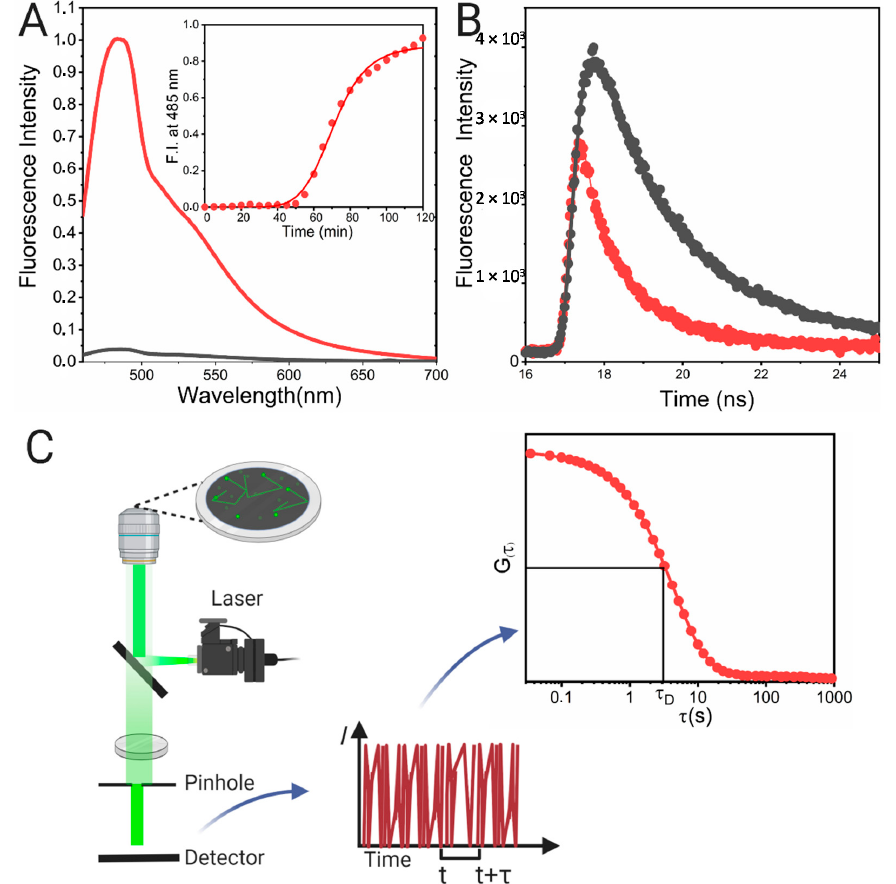
Figure 7. ( A ) Fluorescence spectra of Thioflavin T bound to BSA fibrils (red) in comparison to the probe without it (black). Inset: the kinetic of fibrils formation followed by fluorescence emission at 485 nm. ( B ) Lifetime curve of a Tyr following the aggregation process of a protein. Black and red curves stand for a higher and a lower protein concentration, respectively. ( C ) Fluorescence Correlation Spectroscopy (FCS). Left: schematic representation of a confocal microscope. In the upper image, we could see a detail of the observation volume and fluorescent particles diffusing. Right: the lower and the upper figures are generic examples of a correlation experiment. The lower graph shows fluorescence intensity versus time. The fluctuations are the product of the molecules transit in the confocal volume. The upper graph is the correlation curve obtained from the fluctuations. τ D represents the half time of residence in the confocal volume. This figure was created with Biorender.com.